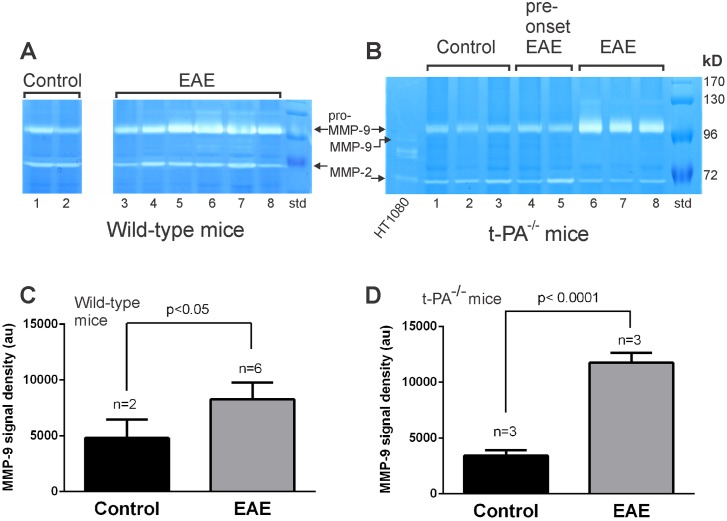
MMP-9 levels are increased in spinal cord extracts from wild-type and t-PA-/- mice following induction of EAE.Spinal cord extracts (20 μg per lane) from MOG35-55 immunized t-PA-/- and wild-type mice at NSS stage 3 of EAE were subjected to SDS-PAGE electrophoresis and gelatin zymography. As shown, both wild-type and t-PA-/- mice demonstrated an increase in proMMP-9 but there was no significant change in levels of MMP-2. The increase in proMMP-9 was not seen in t-PA-/- mice at an early stage of EAE (pre-onset, NSS stage 1.5). As a control for active MMP-9 activity, conditioned media from HT1080 fibrosarcoma cells were included that constitutively express pro-MMP-9 (left lane of B). pro-MMP-9 in the HT1080 samples was activated using amino-phenyl mercuric acetate (APMA) to convert pro-MMP-9 into its active form (shown on the gel). The signal intensities (in arbitrary units; “au”) for MMP-9 in wild-type (A) and t-PA-/- mice (B) were quantitated by densitometry and presented in 4C and 4D, respectively.